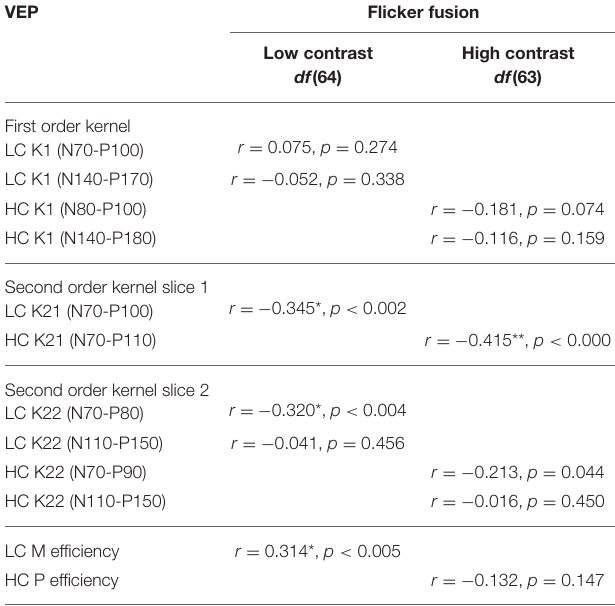
TABLE 2 | Pearson r and significance level for correlations between low contrast flicker fusion and the low contrast peak-to-peak amplitudes and the M efficiency ratio of the VEP, as well as correlations between high contrast flicker fusion and the high contrast peak to peak amplitudes and P efficiency ratio of the VEP.